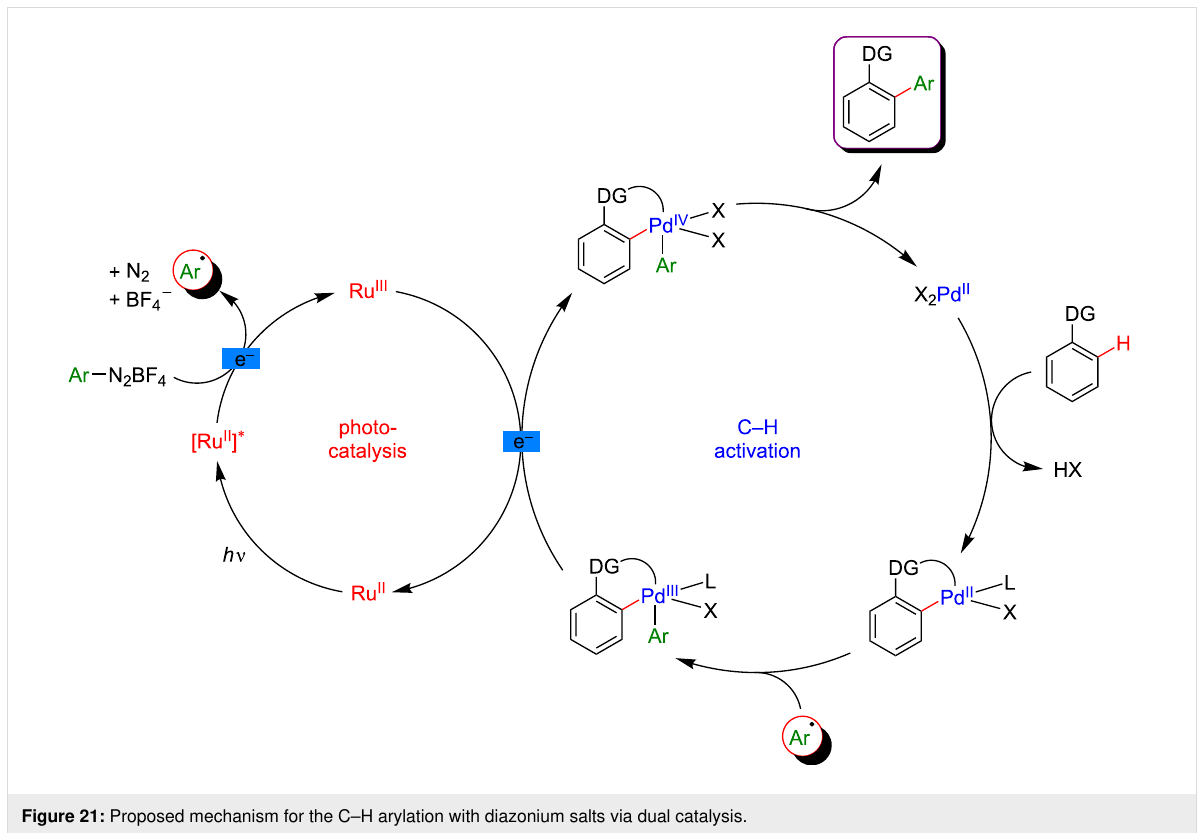
Figure 21: Proposed mechanism for the C–H arylation with diazonium salts via dual catalysis.